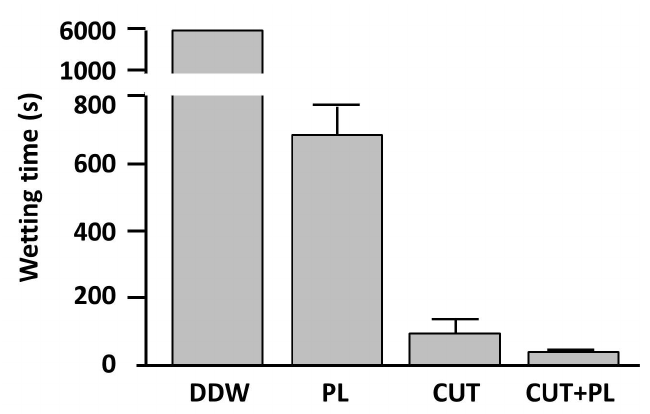
Figure 2. Wetting times in seconds after treatment of cotton garments. DDW, control without enzymes; PL, pectinase alone; CUT, cutinase alone; CUT + PL, mixture of pectinase and cutinase. Adapted from